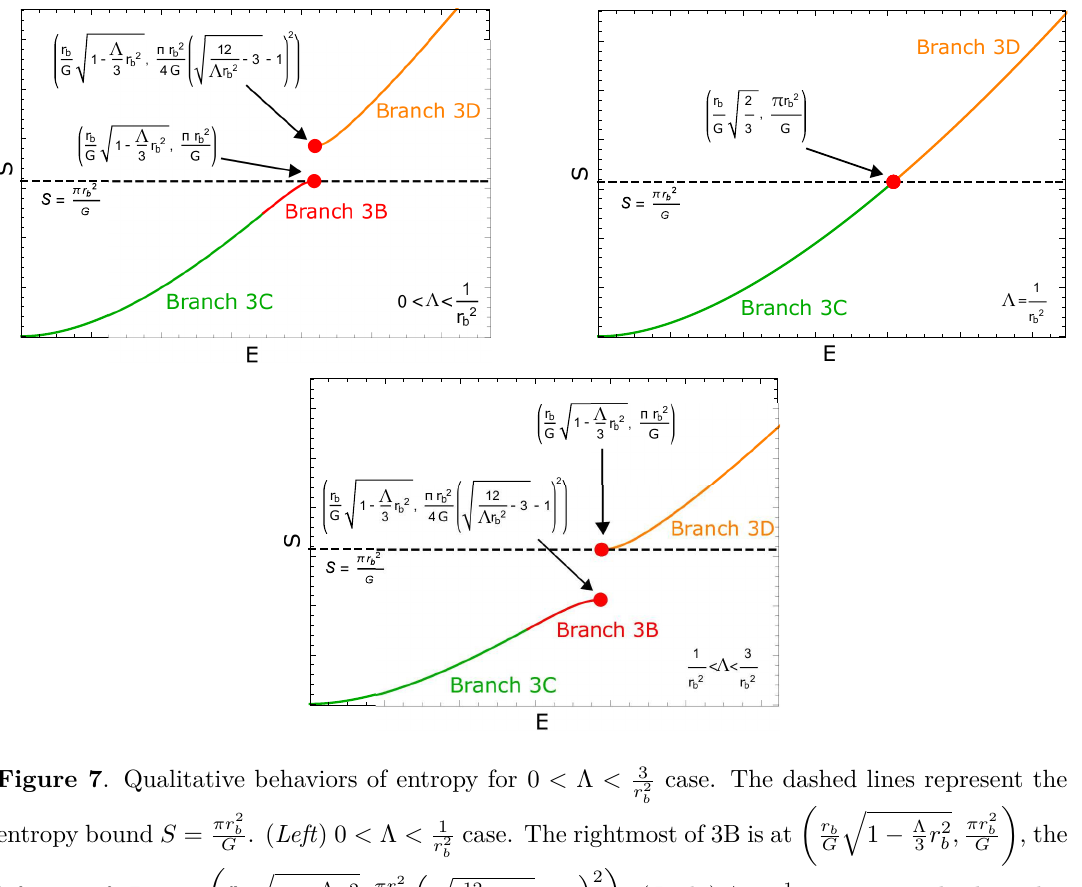
case. The dashed lines represent the r 2 b (cid:18) (cid:19) q 2 . ( Left ) 0 < Λ < 1 case. The rightmost of 3B is at 1 − Λ , the r b r 2 , πr b b G G 3 G r 2 b (cid:18) q (cid:16)q (cid:17) 2 (cid:19) 2 1 − Λ . ( Right ) Λ = 1 case. For only this value r b 12 r 2 , πr − 3 − 1 b b G 3 4 G Λ r 2 r 2 b b < Λ < 3 r 2 r 2 b b (cid:18) (cid:19) q 2 1 − Λ and the rightmost of 3B r b r 2 , πr b b G 3 G (cid:18) q (cid:16)q (cid:17) 2 (cid:19) 2 1 − Λ r b 12 r 2 , πr − 3 − 1 b b G 3 4 G Λ r 2 b